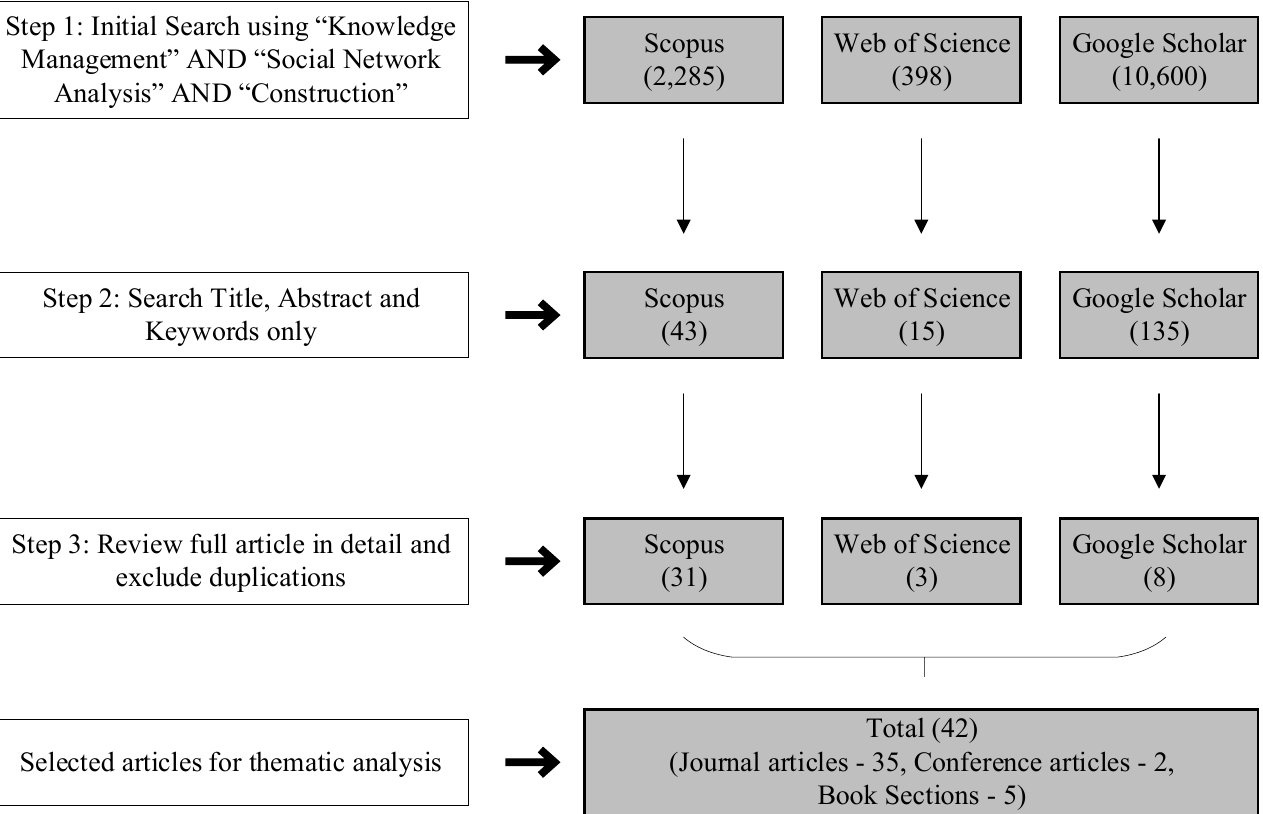
Figure 1. Selection of articles for systematic review.